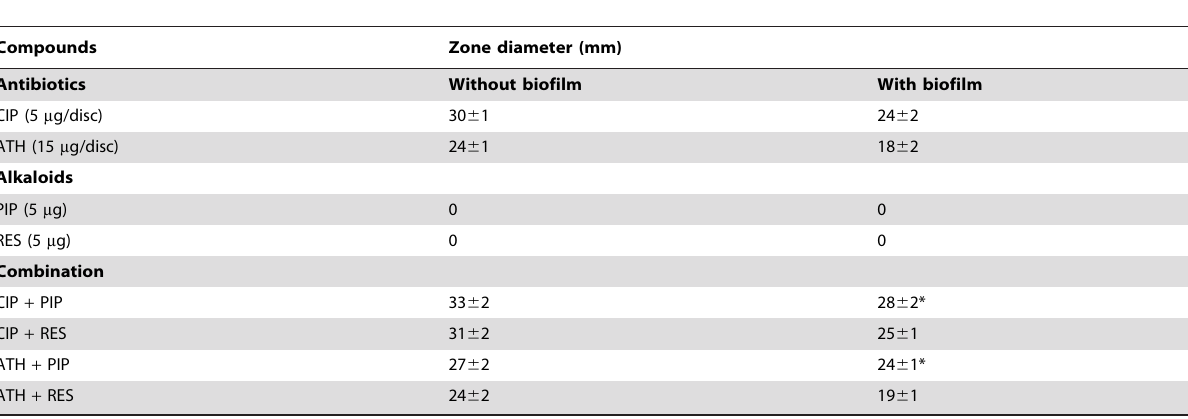
Table 2. Penetration of antibiotics ciprofloxacin (CIP) and azithromycin (ATH) through pre-formed E. coli CFT073 biofilms in presence and absence of piperine (PIP) and reserpine (RES).